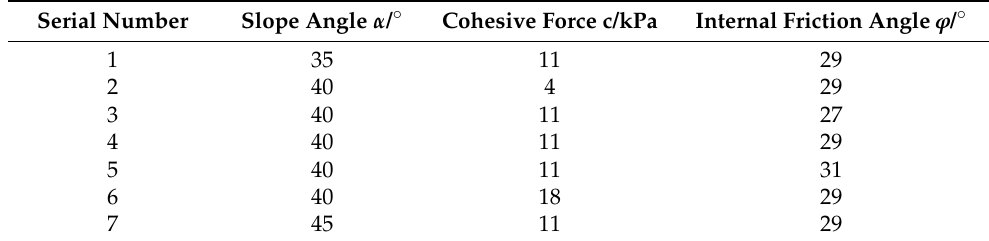
Table 2. Sensitivity analysis test group of complete-weathering layer